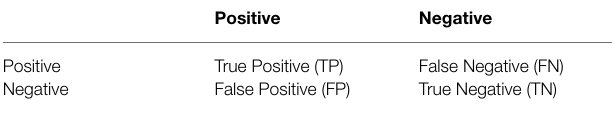
TABLE 2 | Table of confusion matrix